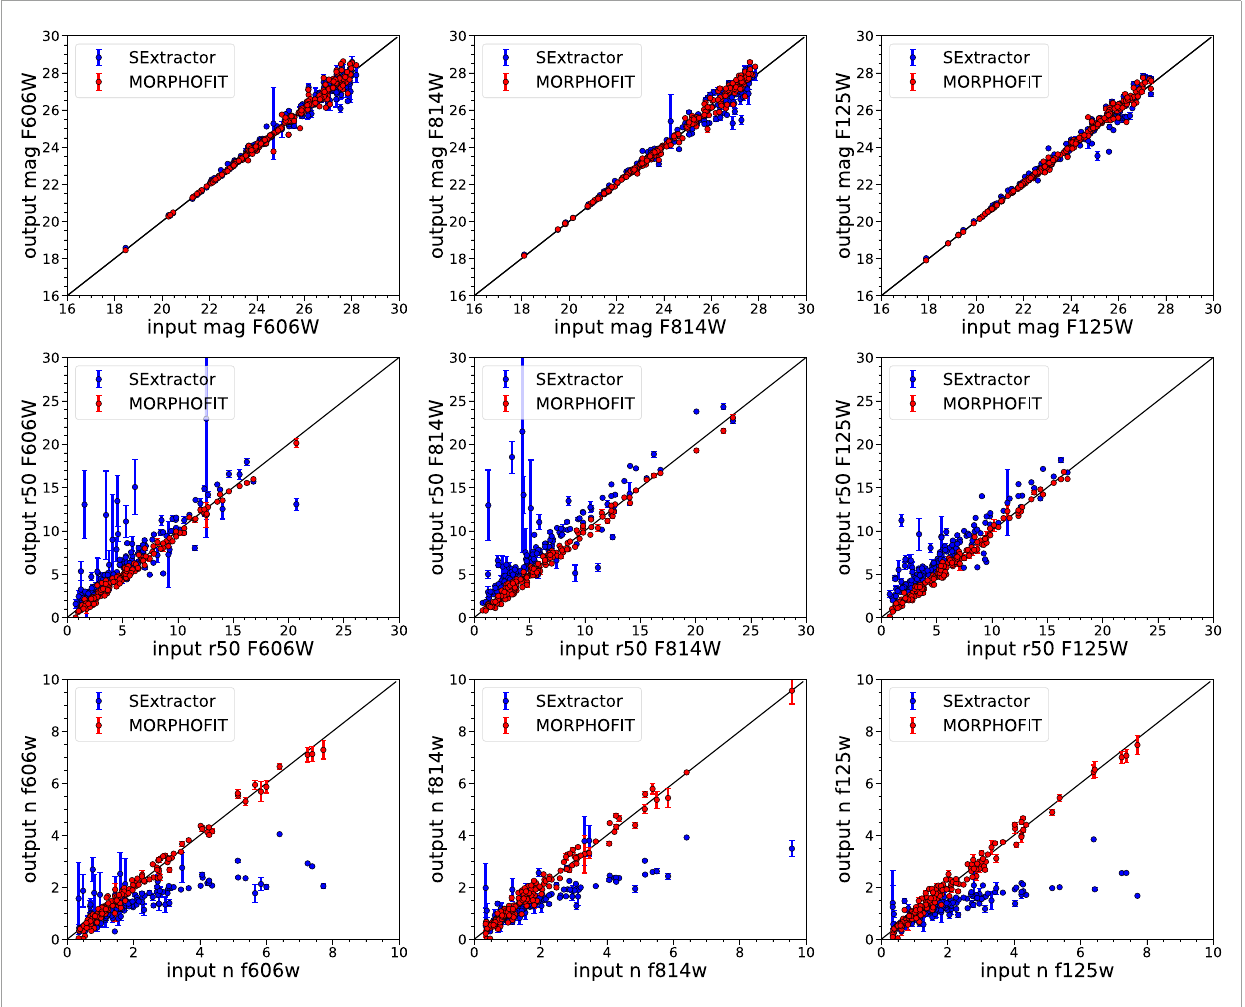
FIGURE A1 The top, middle and bottom panels show the comparison between the input simulated galaxy magnitudes, the input simulated galaxy effective radii, the input simulated galaxy Sérsic indices and the best-fitting magnitudes, effective radii, Sérsic indices from MORPHOFIT (in red) and SEXTRACTOR (in blue), respectively. Magnitudes are in the AB system, while the effective radii are expressed in units of pixels. mag , r e and n refer to the total magnitude, the effective radius and the Sérsic index of the input and fitted Sérsic profile. For each row, we only select a sub-sample of the seven wavebands for plot clarity. The black solid line represents the one-to-one relation between the input and the best-fitting